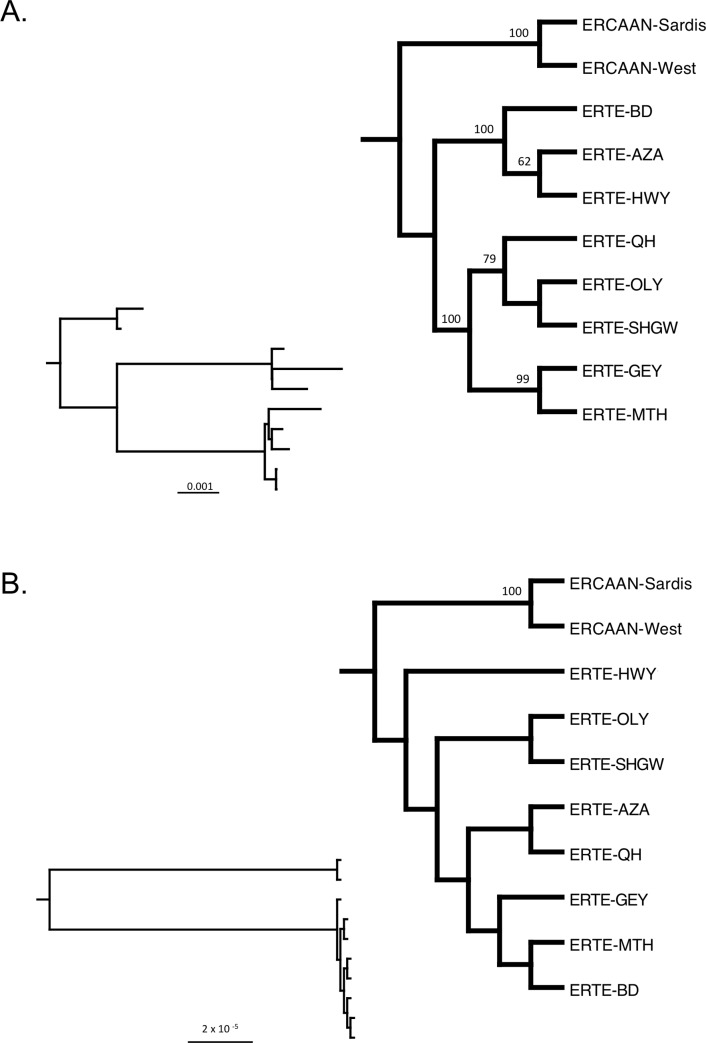
Maximum likelihood phylogenetic results for the eight populations of Erysimum teretifolium.Phylogenetic relationships were determined from the nearly complete chloroplast genomes (A) and complete nuclear ribosomal cistron (B). The trees are rooted with two closely related ERCAAN samples and analyzed with RAxML. Bootstrap values were shown above branches (only BS > 50% are displayed). The larger cladograms show relationships among populations while branch lengths are displayed in the inset phylograms with populations in the same vertical order. For the phylograms, branches are drawn proportional to the number of substitutions per site (see scale bar). Population abbreviations are defined in Table 1.